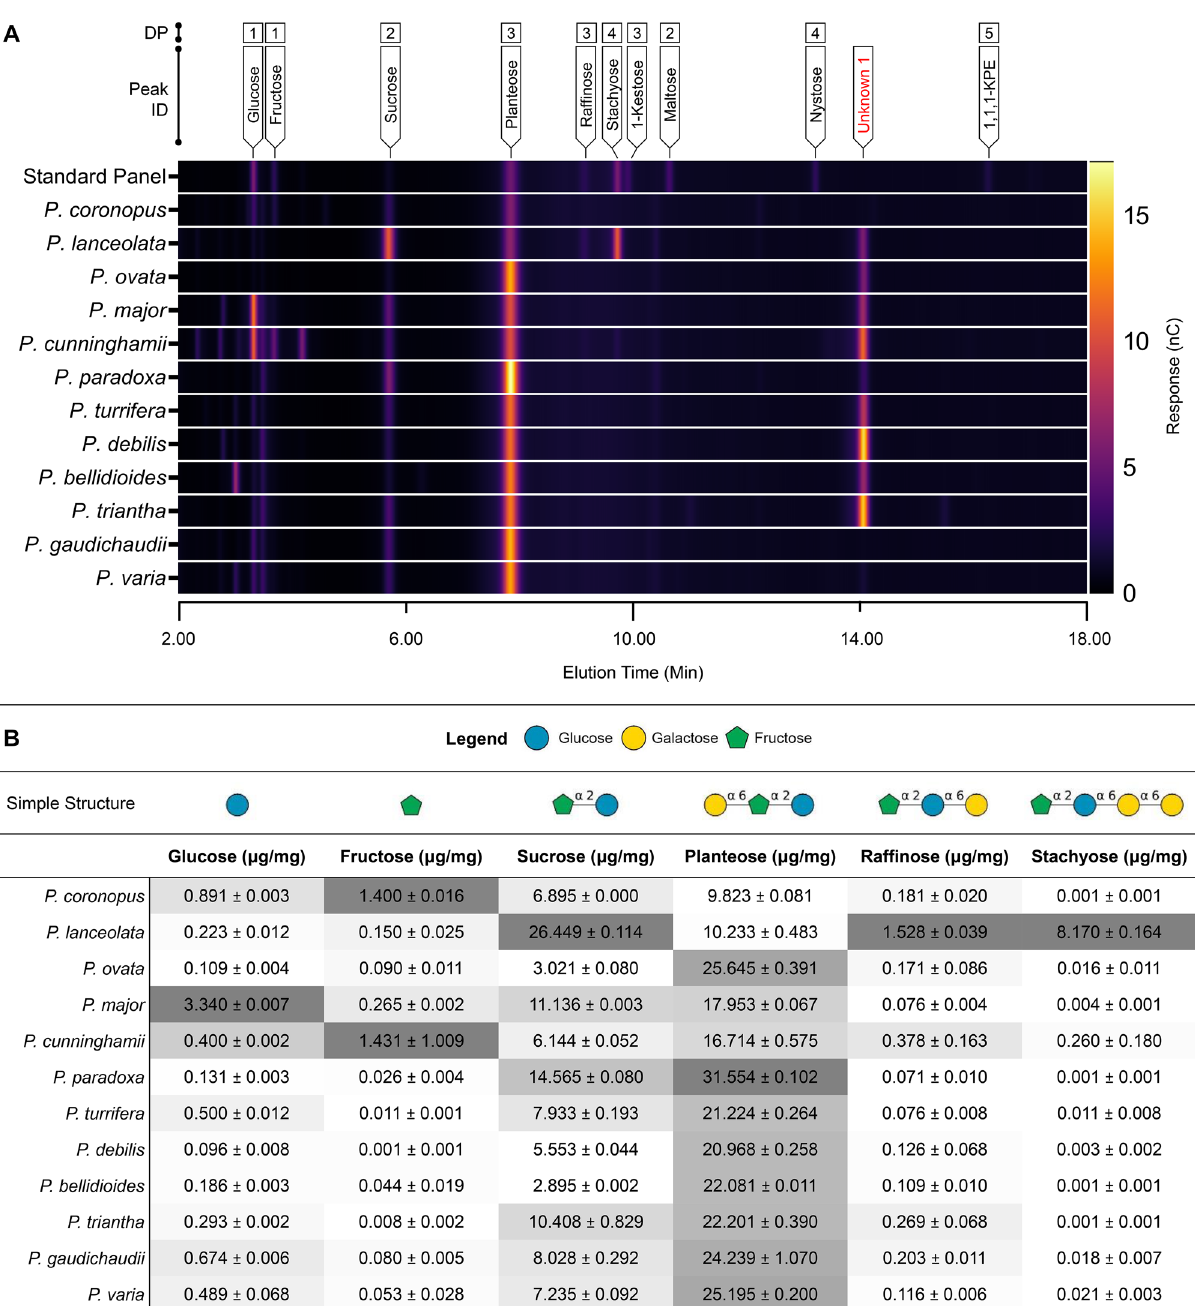
Figure 6. Soluble sugar profiling of Plantago seeds. ( A ) Chromatographic data presented in heatmap form to highlight differences in chromatographic profile between species. Chromatographic data has been cropped to an elution period that includes saccharides with a low degree-of-polymerisation (DP) (2–18 min). For simplicity, chromatographic data of standard runs (standard panel: a combined low DP saccharide suite, planteose and stachyose) were combined. ( B ) Quantification of key low DP saccharides and their schematic structure. A grey scale (dark grey, highest value; white, lowest value) has been used to display differences in abundance of one type between species. Values are means and standard deviation of three replicates. Abbreviations: 1,1,1- KPE =